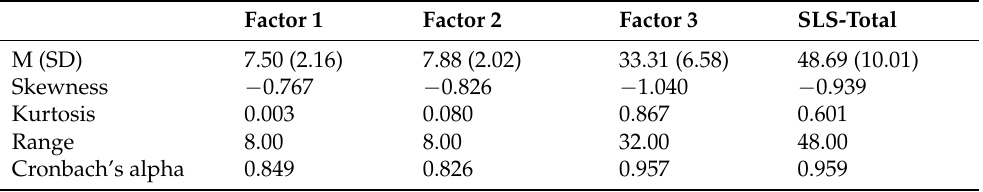
Table 5. Descriptive statistics of the three factors of the SLS-12 (N = 941). Factor 1 Factor 2 Factor 3 SLS-Total